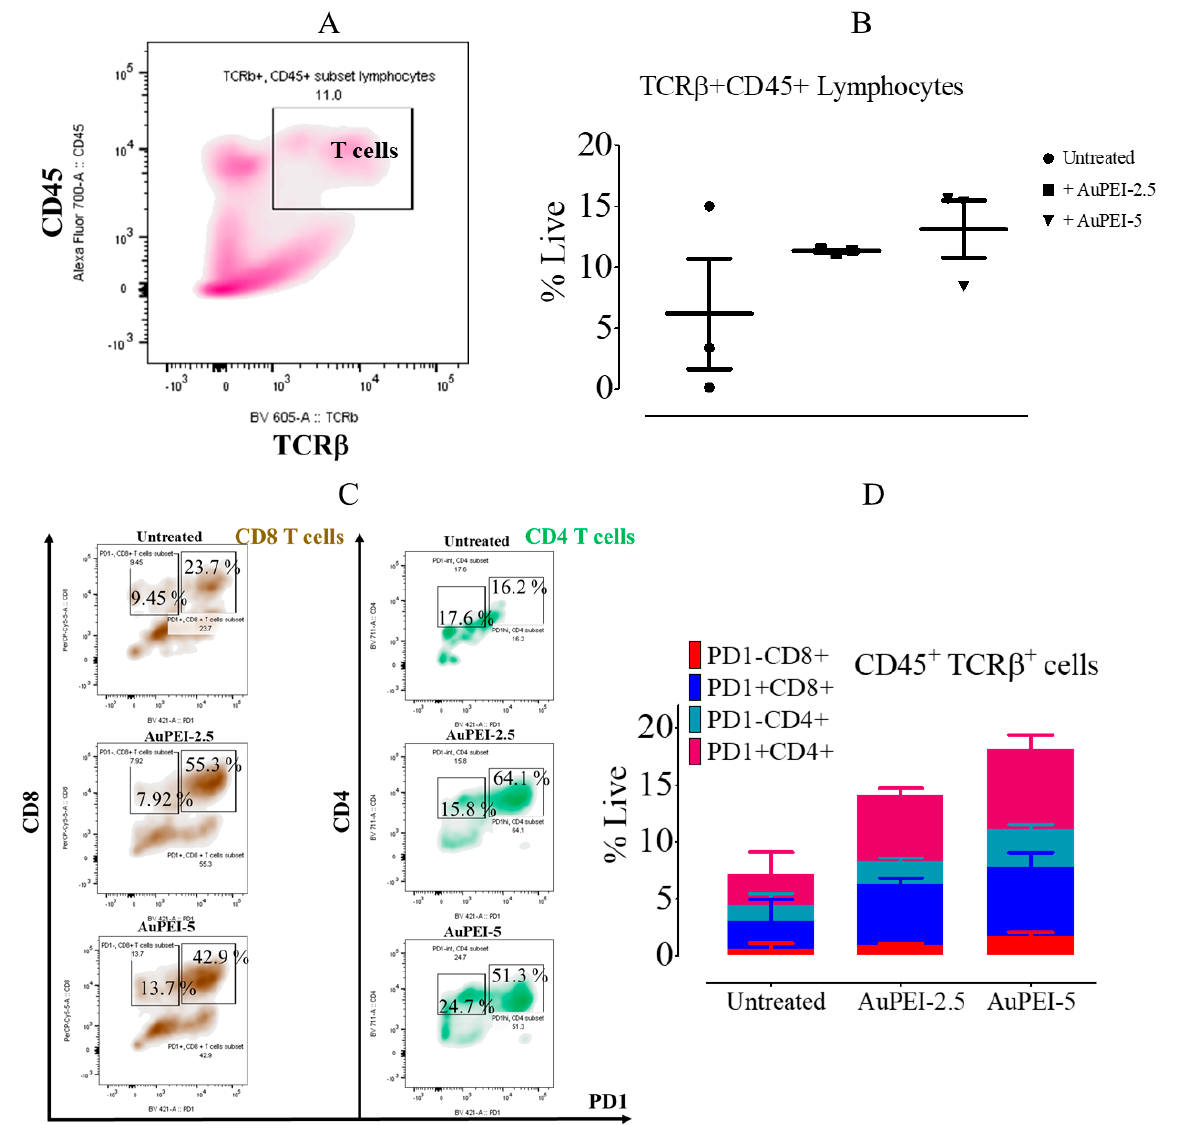
Figure 5. MET-1 tumor-infiltrating lymphocyte (TIL) distribution upon AuPEI nanocomposite i.t. injection. MET-1-bearing mice were injected i.t. with 0.5 mg/mL Au (40 µL) AuPEI nanocomposites and euthanized 24 h after. ( A ) Gating strategy to differentiate TILs within the tumor cell population. ( B ) Percentage of total TILs in tumors. ( C ) Representative dot-plot showing expression of PD-1 by CD4 and CD8 T cells, and ( D ) summary of the distribution of CD4 and CD8 T cells according to PD-1 expression. (Results are shown as mean ± SEM of n = 3 per